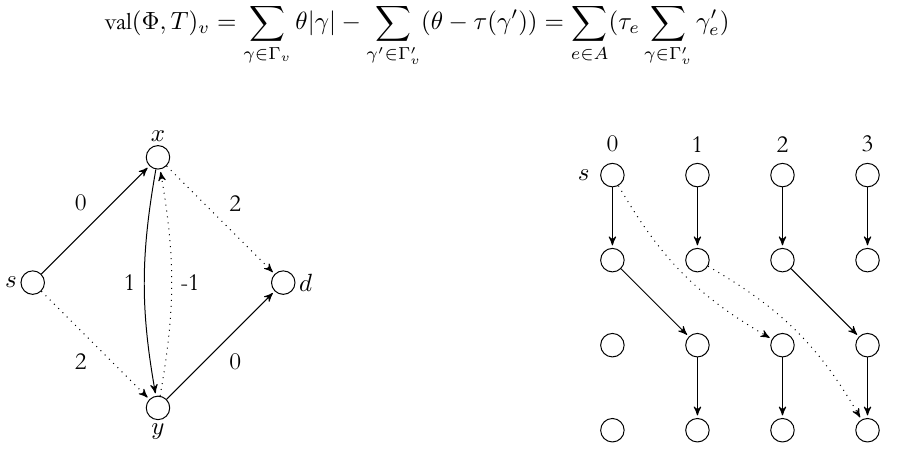
Figure 5: An illustration of backward flow cancellation in generalized temporally repeated flows